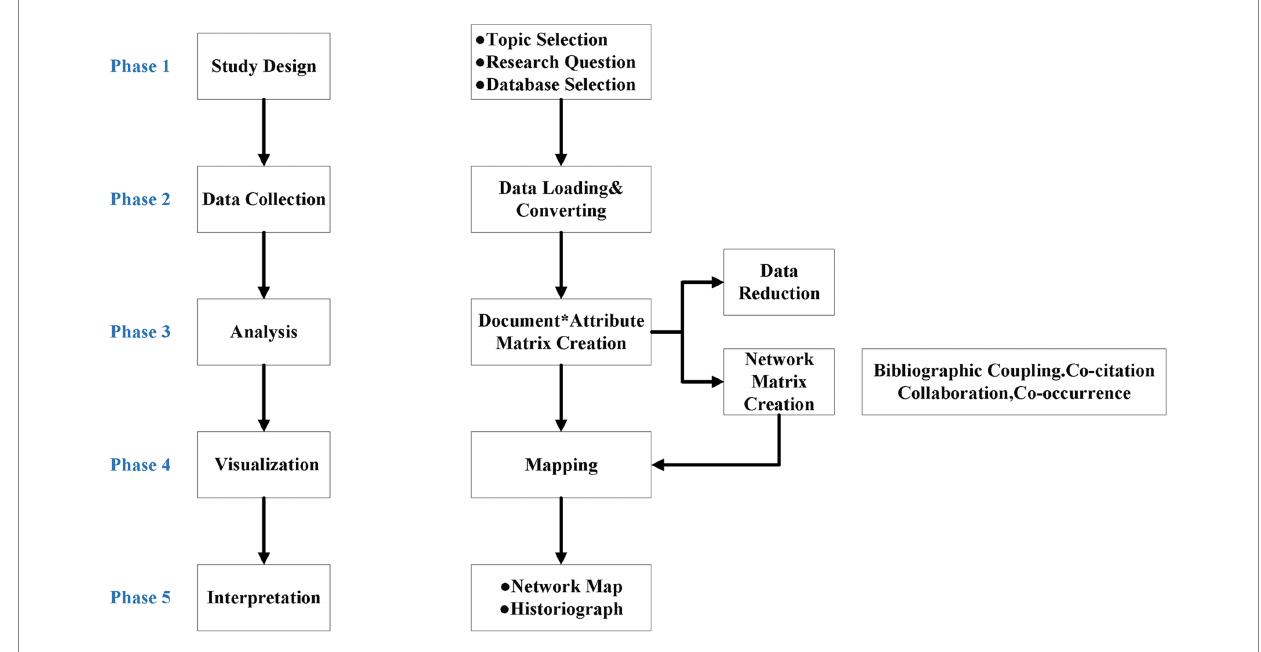
FIGURE 1 Schematic depicting bibliometric analysis methodologies.